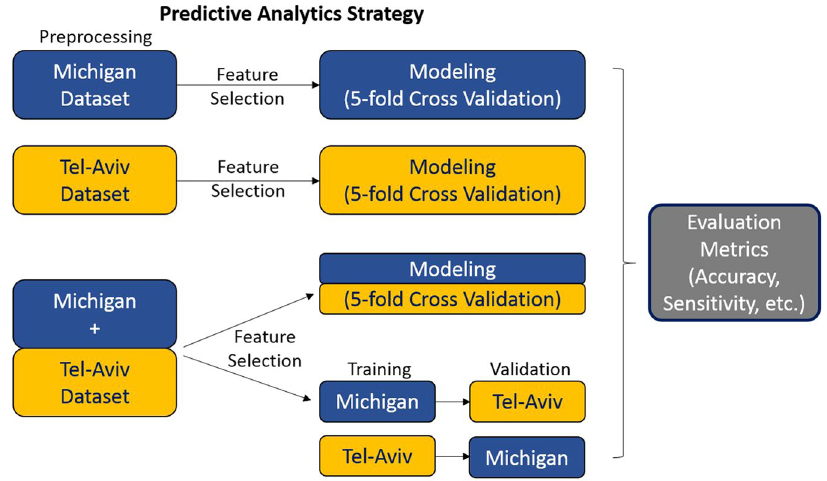
Figure 1. Predictive Analytics Strategy: (Top) Identify critical features and build predictive models independently on the Michigan and the Tel-Aviv datasets, respectively. (Bottom) Harmonize and merge the two data archives and perform the same analytics on the aggregate data. The bottom-right branch of the diagram illustrates the process of training the models on one of the datasets and (externally) validating their accuracy on the other complementary